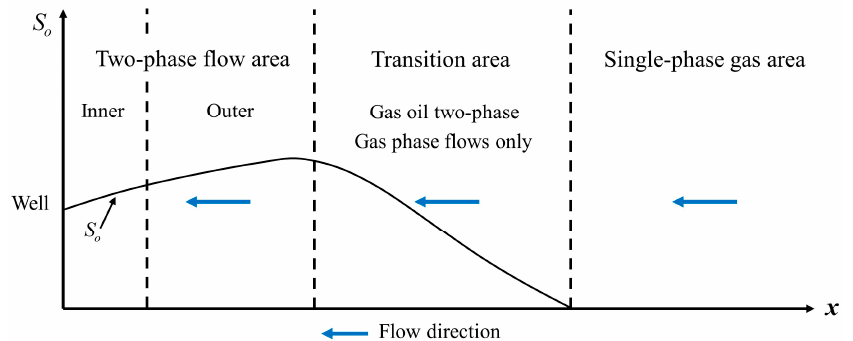
Figure 2. Schematic diagram of four-zone flow model.